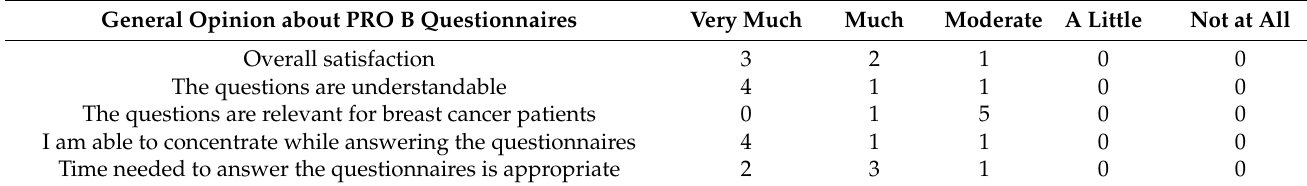
Table 1. General opinion about PRO B questionnaires in the application ( n =